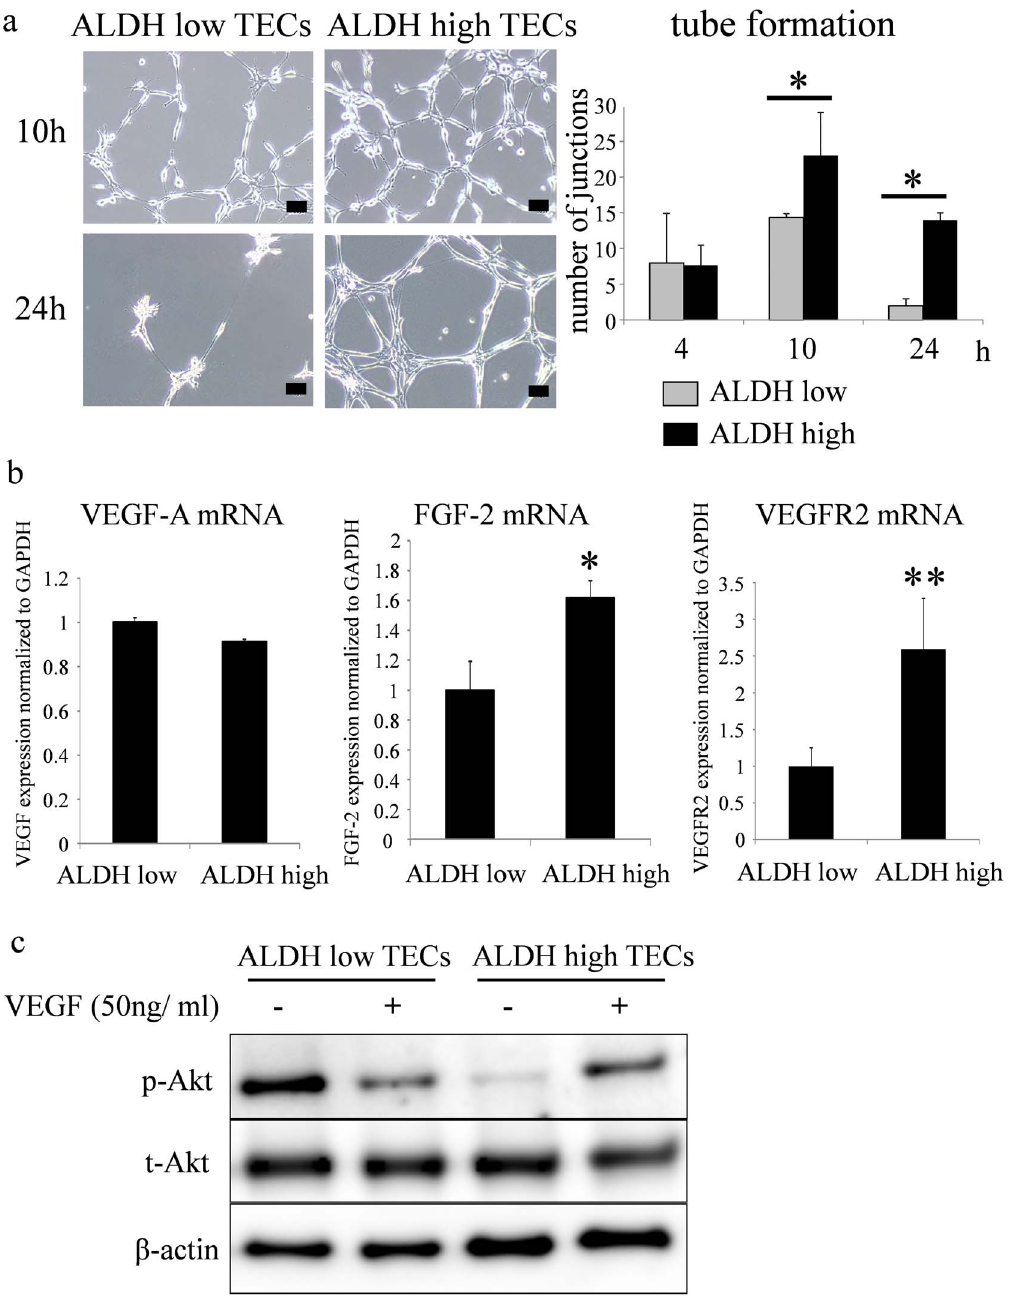
Figure 4. ALDH high TECs show a highly angiogenic phenotype. a. The number of tube junctions (arrows) was counted at 10 and 24 h after seeding onto Matrigel in a tube formation assay in vitro (*p , 0.05). Scale bar: 50 m m. b. Relative expression of VEGF-A, FGF-2, and VEGFR2 to GAPDH in ALDH high/low TECs was measured using real-time RT-PCR (*p , 0.05; **p , 0.01). c. Levels of p-Akt were determined by western blotting using an anti-p-Akt antibody. The membrane was stripped and re-incubated with anti-total Akt (t-Akt) and - b -actin antibodies. After treatment with VEGF for 20 min, Akt was more activated in ALDH high TECs than that in ALDH low